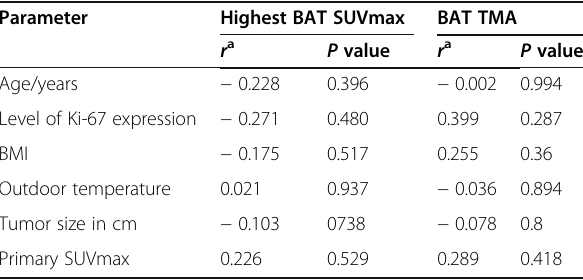
Table 4 Correlation between highest SUVmax and TMA of activated BAT, and patient ’ s age, level of Ki-67 expression, BMI, outdoor temperature, tumor size, and primary SUVmax